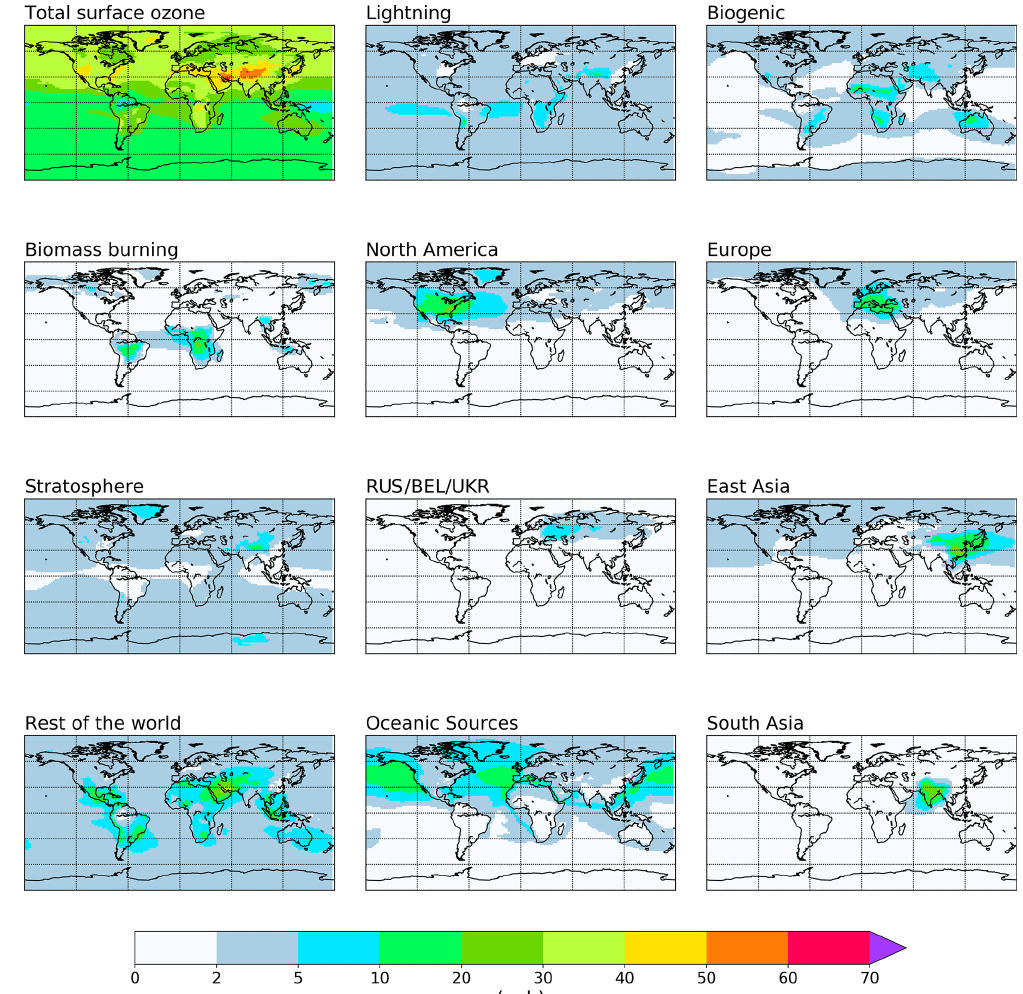
Figure 2. Annual mean surface ozone (ppb) from the NO x -tagged base run. Total ozone is shown in the top left panel. Tagged ozone tracers are shown in the other panels. “RUS/BEL/UKR” refers to Russia, Belarus, and the